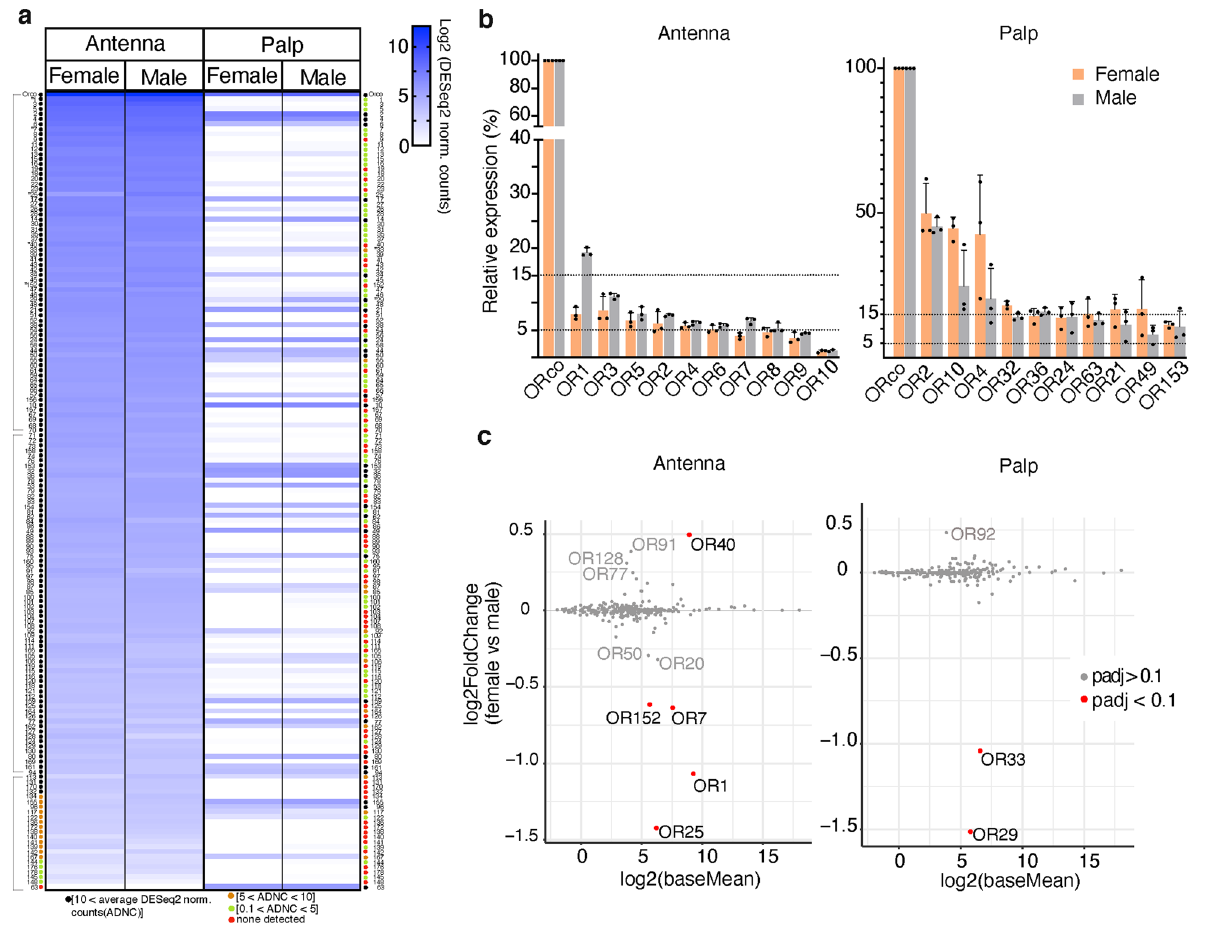
Figure 2. Expression of putative SameORs by tissue type and sex. RNAseq reads were aligned against identified putative SameORs and quantified. All data shown are based on DESeq2 normalized read counts. Quantification was performed in three replicates per condition. ( a ) Expression heat map of the 159 putative SameORs contained in Database A. Data are sorted according to antenna expression from highest to lowest normalized counts. Each row corresponds to the same putative SameOR in all columns. Colored circles next to each named SameOR indicate expression level: black, 10 < average < ~ 4300; orange, 5 < average < 10; green, 0 < average < 5 normalized counts. Red: none detected. Light gray lines indicate grouped OR labels; see Supplementary Fig. 3 for an enlarged version. Asterisks: statistically significant differences in expression between female and male in antenna or palp tissues from panel ( c ). ( b ) Expression of the 10 most expressed putative SameORs in female (orange bars) and male (gray bars) tissue. Expression level is given relative to Orco. Error bars: standard deviation. ( c ) Differential expression between female and male in antennae (left panel) and palp (right panel) tissues. Red: differentially expressed putative SameORs padj <